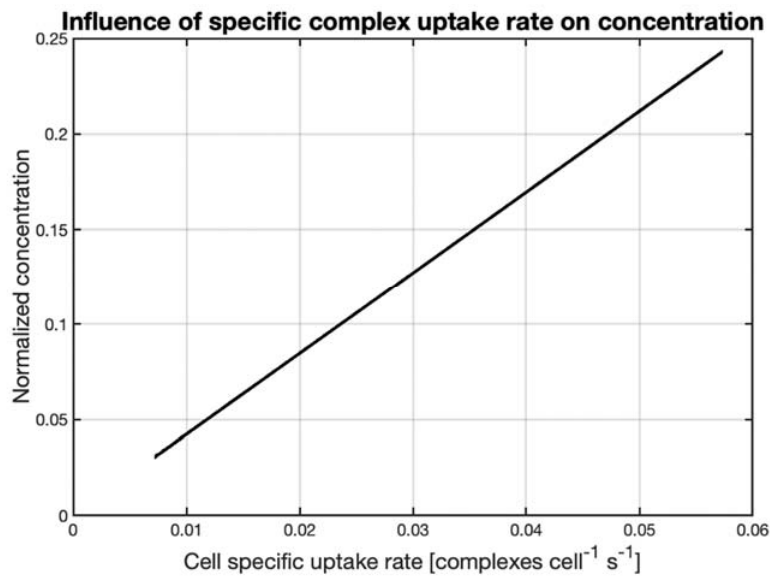
Figure 4. Theoretical normalized concentration of PEI-DNA complexes, calculated by Equation (5), as a function of the cell-specific polyplex uptake rate for a polyplex radius of 300 nm in a spinner flask stirred at 50 RPM. The cell-specific uptake rate was estimated based on PEI transfection completion obtained after a maximum of 4 h, corresponding to an uptake rate of 0.01 complexes cell − 1 s − 1 . The PEI-DNA complexes concentration was estimated by assuming a polyplex density similar to that of a protein, and a polyplex radius of 300 nm, which was the average radius for a 5 min incubation.